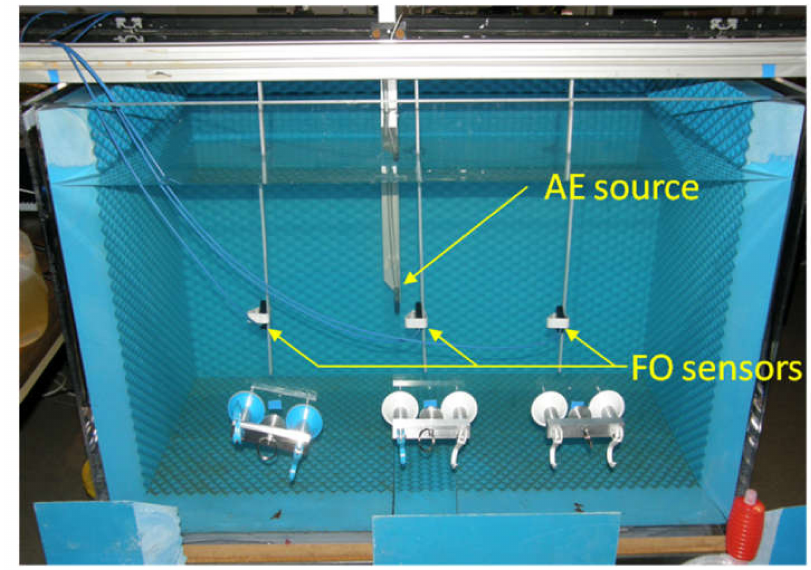
Figure 10. Detail of the acoustic characterization test